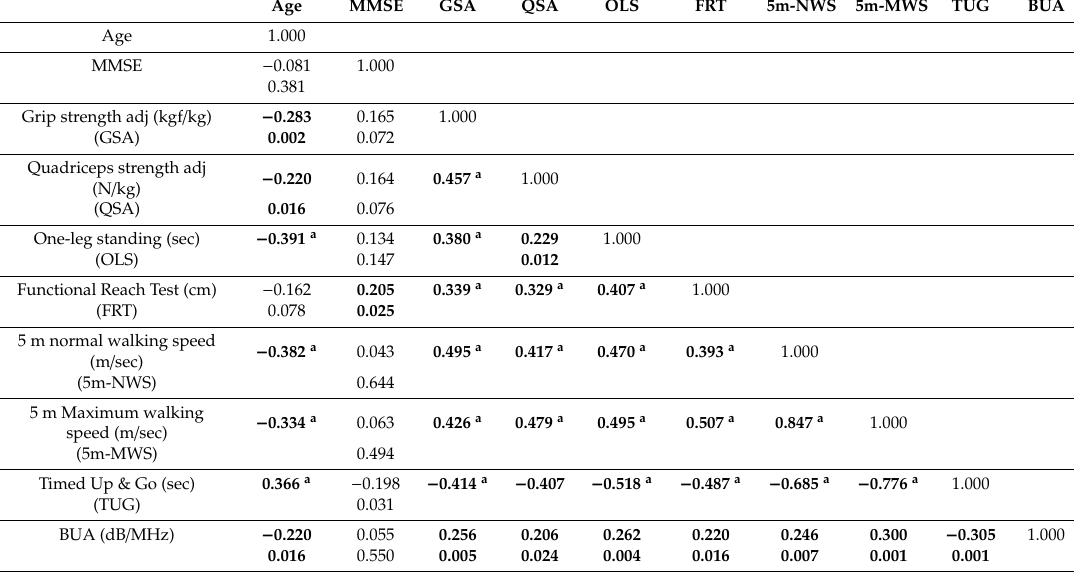
Table 2. Spearman’s rank correlation coe ffi cients among all physical performance measurements, age, and Mini-Mental State Examination